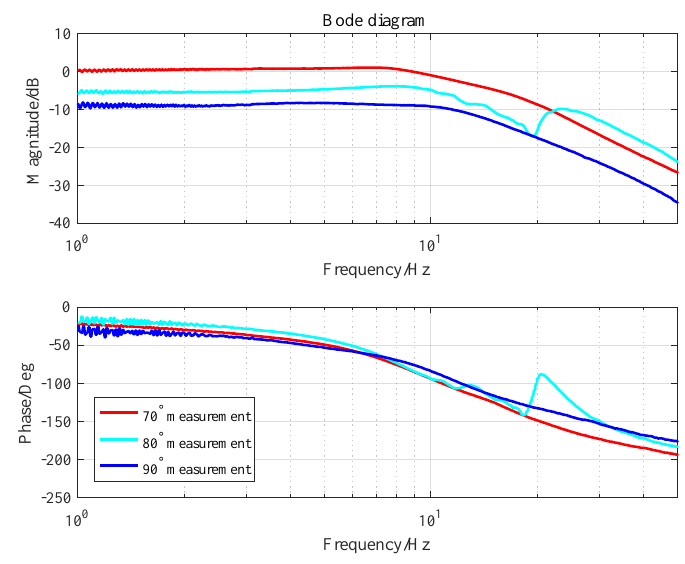
Figure 2. The open-loop frequency characteristics of the plant in different attitudes.